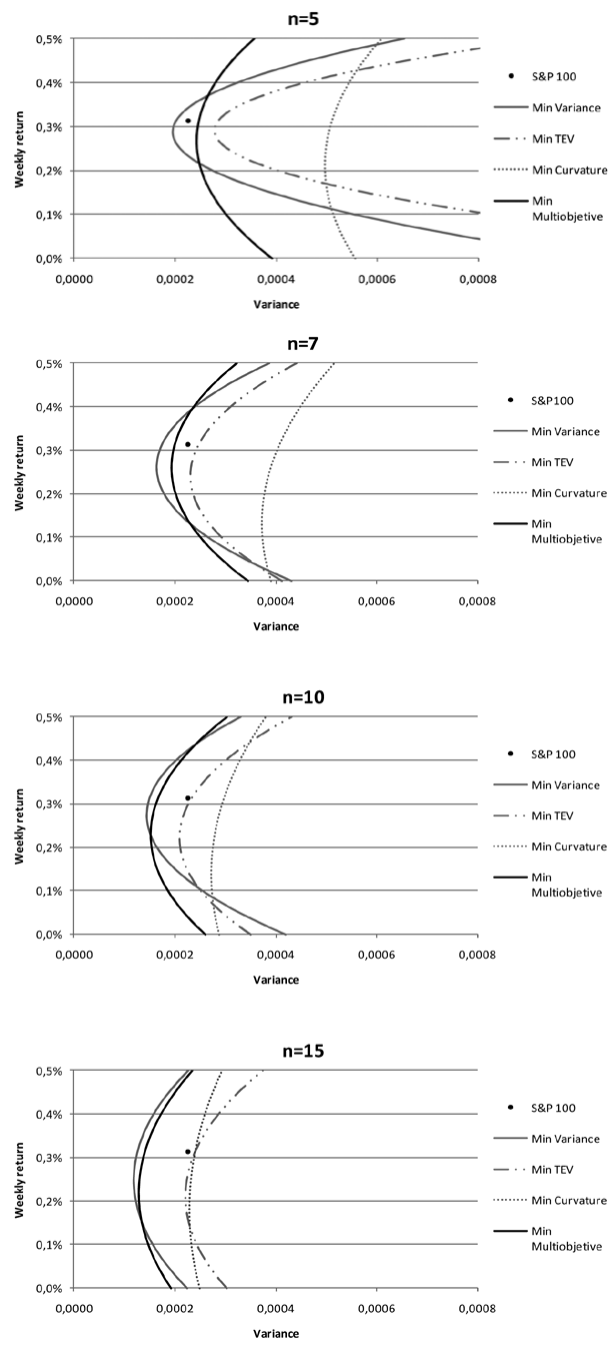
Fig. 2. Graphical representation of the return variance versus the weekly returns for the multiobjective model and the three monoobjective models. Cardinality: n = 5, 7, 10,